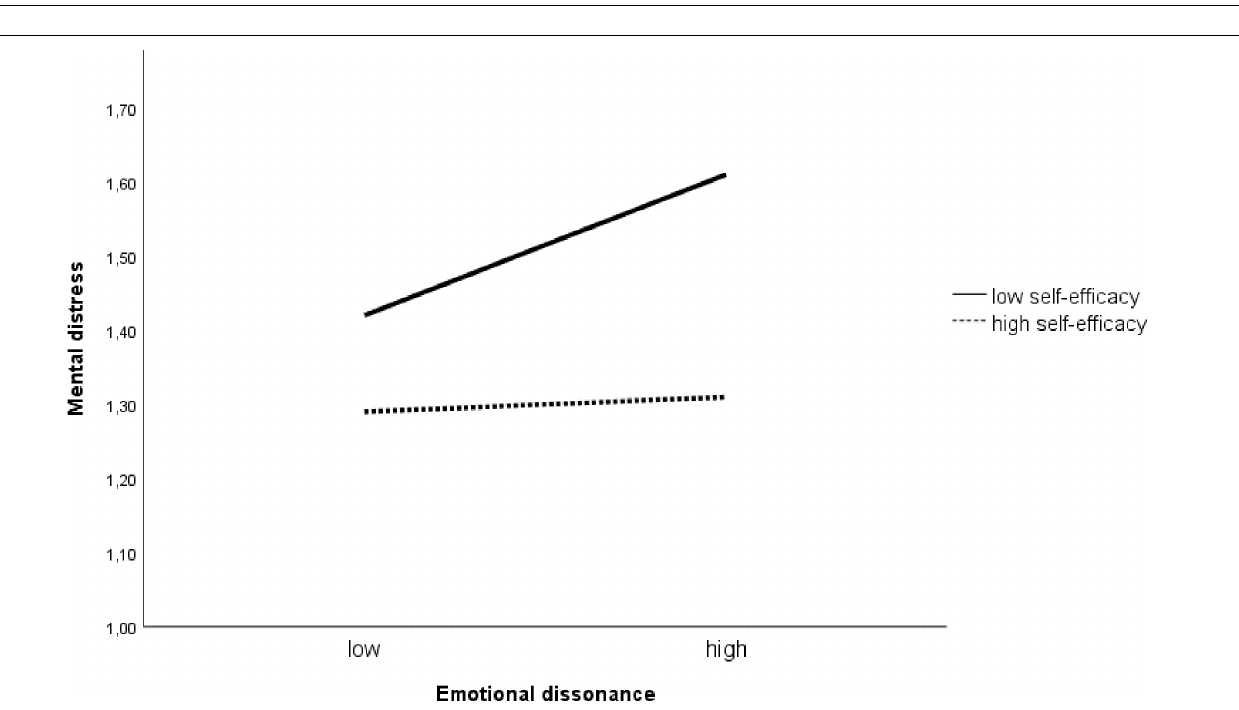
FIGURE 2 | The moderating effect of self-efficacy on the relationship between emotional dissonance and exhaustion ( n = 879).